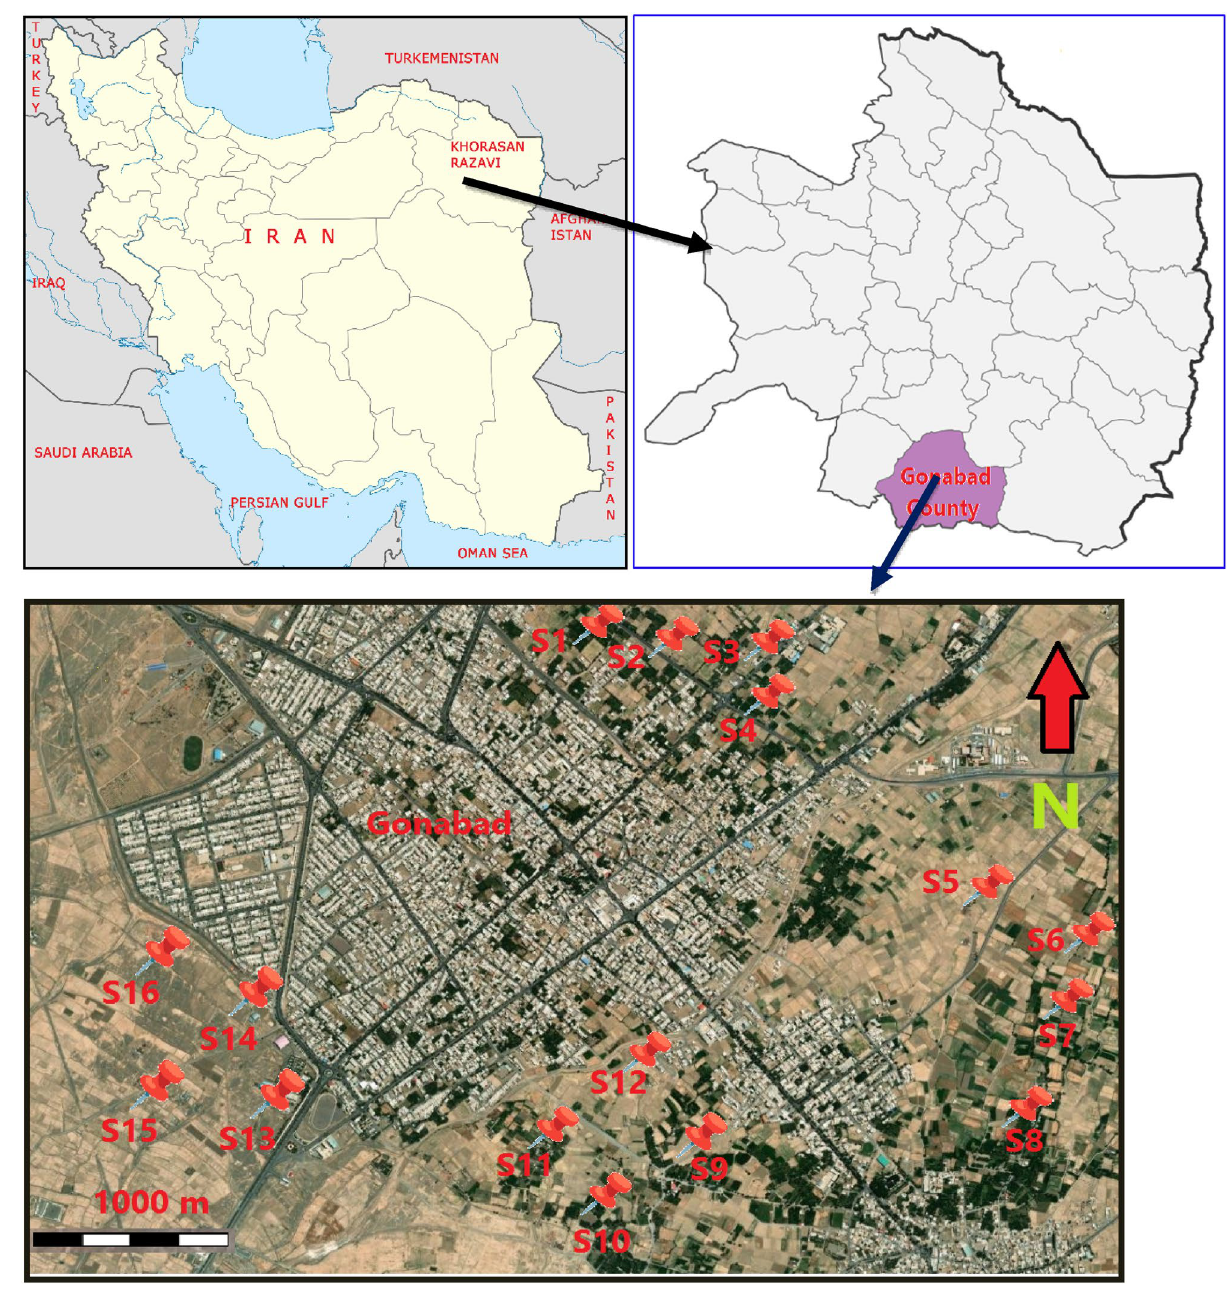
Figure 1. The locations of the farms where soil was sampled in